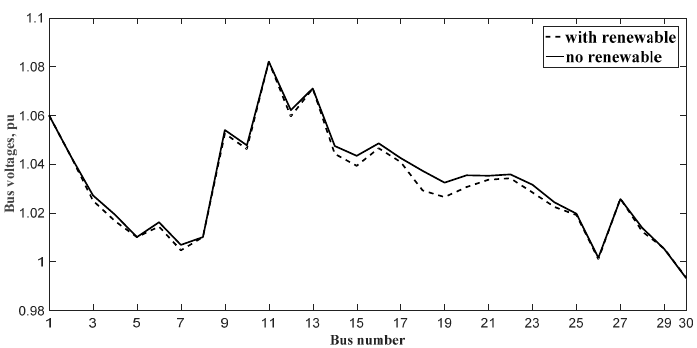
Figure 2. Buses’ voltage magnitude with and without renewable energy generation.